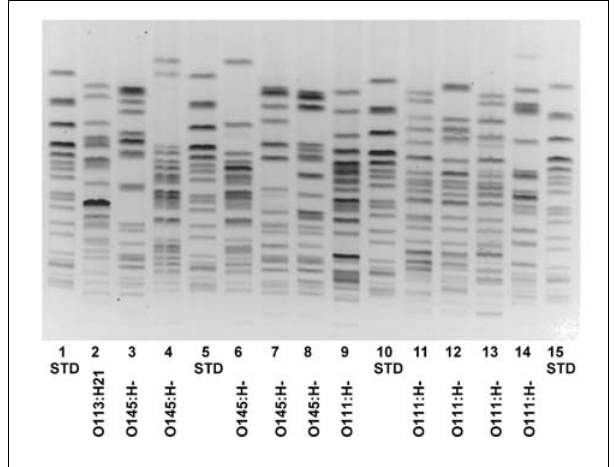
Figure 2) Pulsed-field gel electrophoresis (PFGE) of selected non- O157 verotoxin Escherichia coli serotypes found in Canada. Lanes 1, 5, 10 and 15 contain PFGE standard strain G5244. Serotypes of each isolate tested are included below the lane number